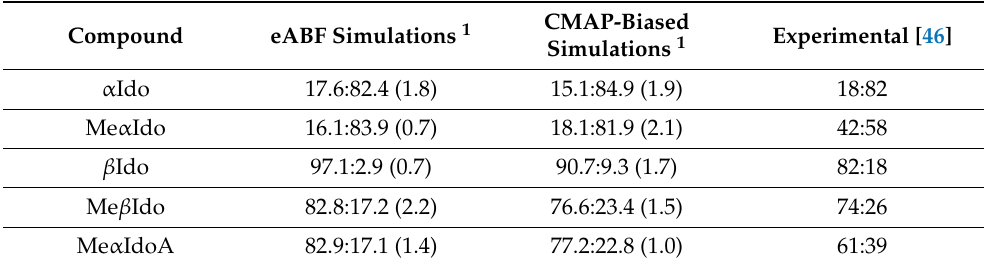
Table 1. 4 C 1 : 1 C 4 ring puckering probability ratios in idose (Ido) and iduronate (IdoA) compounds. Compound